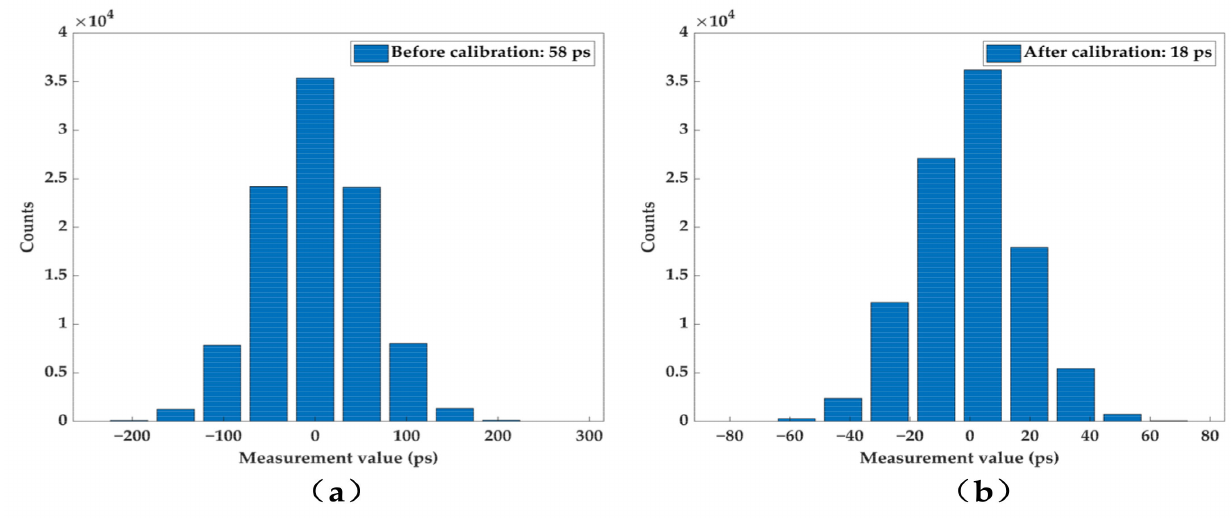
Figure 10. Measurement value of time interval ( a ) before calibration; ( b ) after